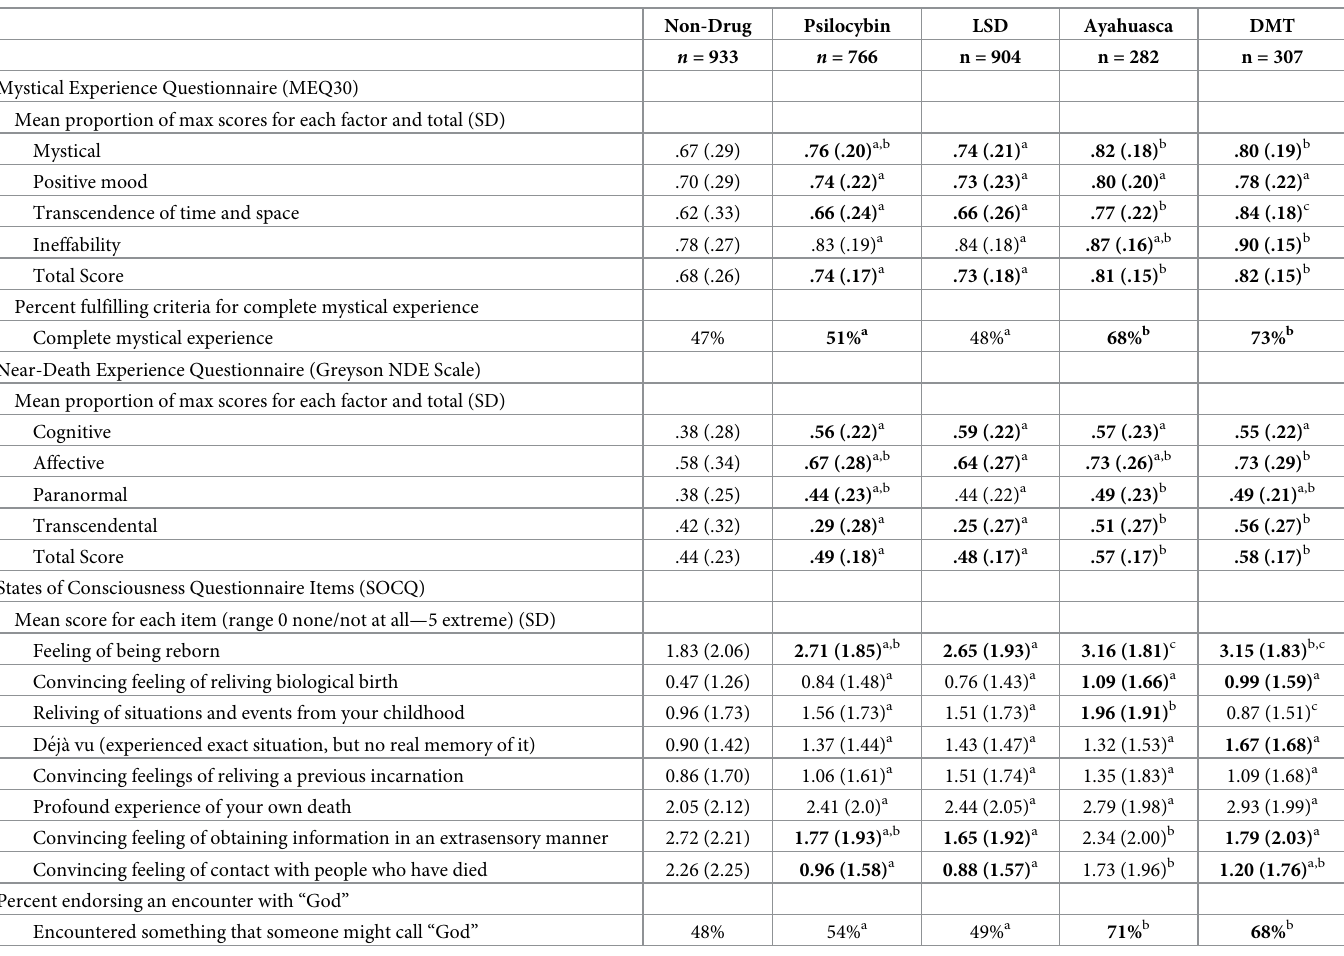
Table 6. Mystical-type and other subjective features of the experience among the Non-Drug, Psilocybin, LSD, Ayahuasca, and DMT groups 1,2